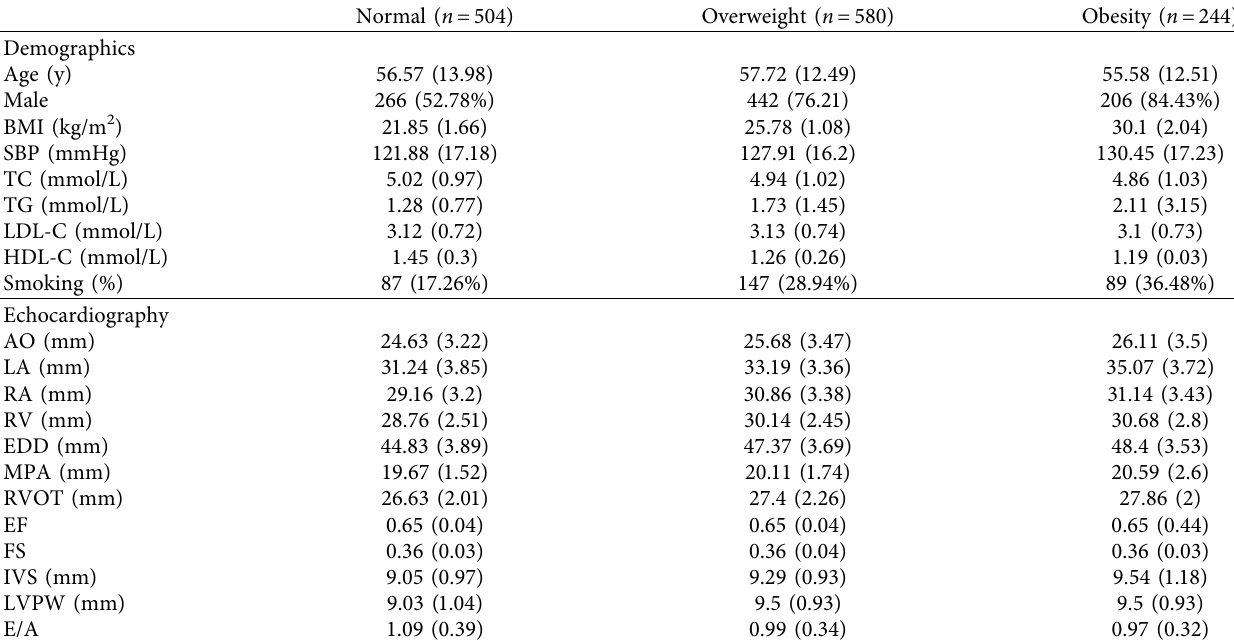
Table 1: Comparison of baseline characteristics and cardiac ultrasound indices in a stratified population based on